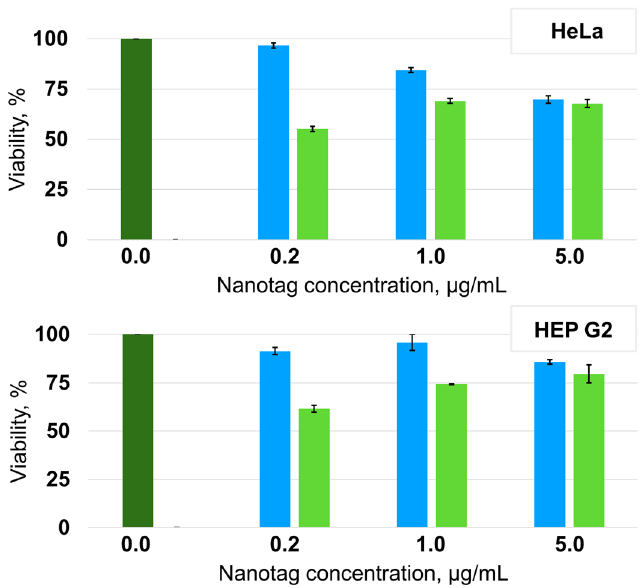
Figure 8. Viability of HeLa and HEP 2G cells after incubation with the nanotags before (blue) and after (green) functionalization with folic acid.